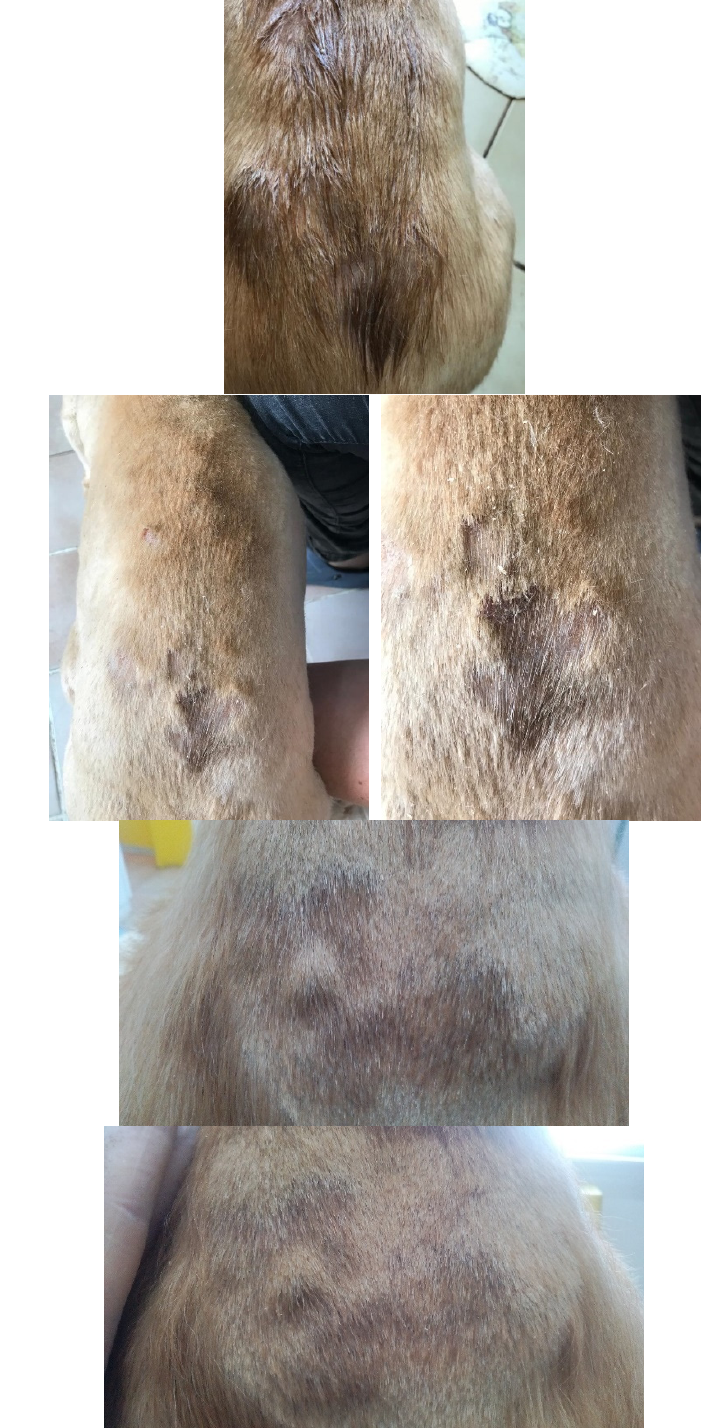
Figure 1. Treatment results of patient 1 with SILVER STOP ® cream. Patient 2. SS ® cream was prescribed twice a day until recovery. A visible result was noticed already on the 7th day when the opening of the fistula and the swelling in the area were decreased. The application of the preparation lasted for 45 days. At the end of the period, the fistula was completely closed and the swelling disappeared (Figure 2). Owners reported no irritation caused by the cream.